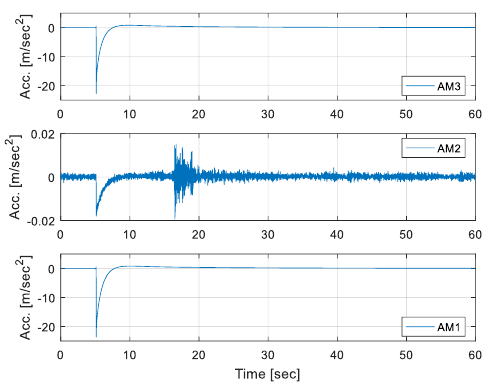
Figure 7. Accelerogram of the signals at 16:37:33 on 19th September 2011 Table 1 Monthly maximum acceleration: